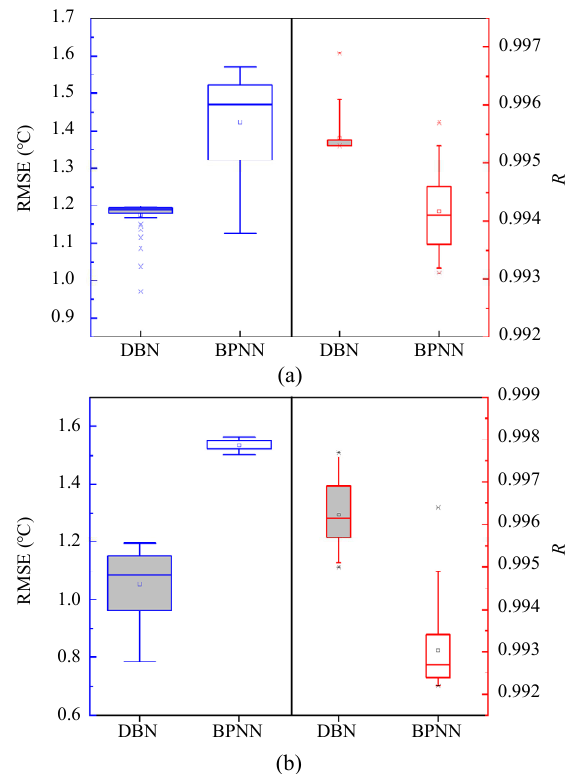
Fig. 9 Statistical analysis of the DBN and BPNN predictions for the two-turn HMF sensor in (a) the heating process and (b) the cooling process. (In the box, the straight line represents the median, and the cubic is the average value. The outlier is denoted by the